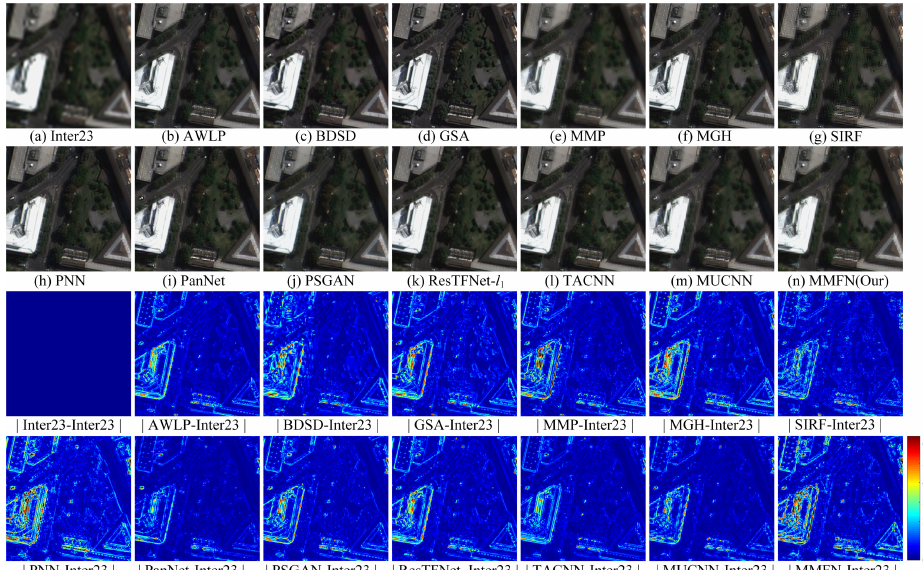
Figure 7. Qualitative comparison at full resolution on the Pléiades dataset. ( a ) Inter23, ( b ) AWLP,